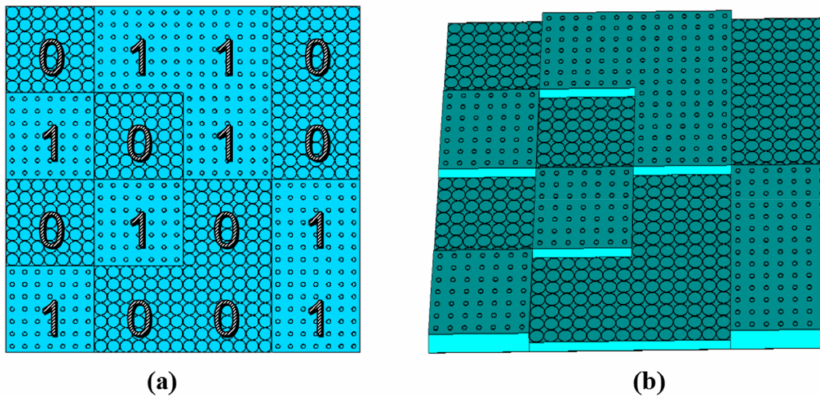
Figure 4. The ( a ) two-dimensional geometry structure and ( b ) three-dimensional geometry